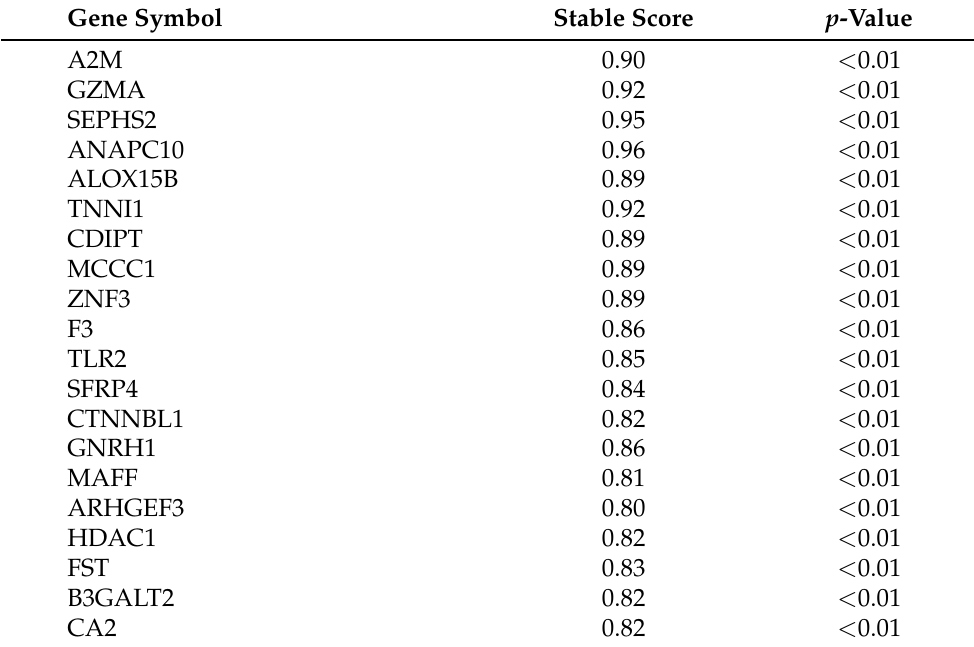
Table 6. The top-20 genes found in the PAAD (pancreas cancer) dataset. Gene